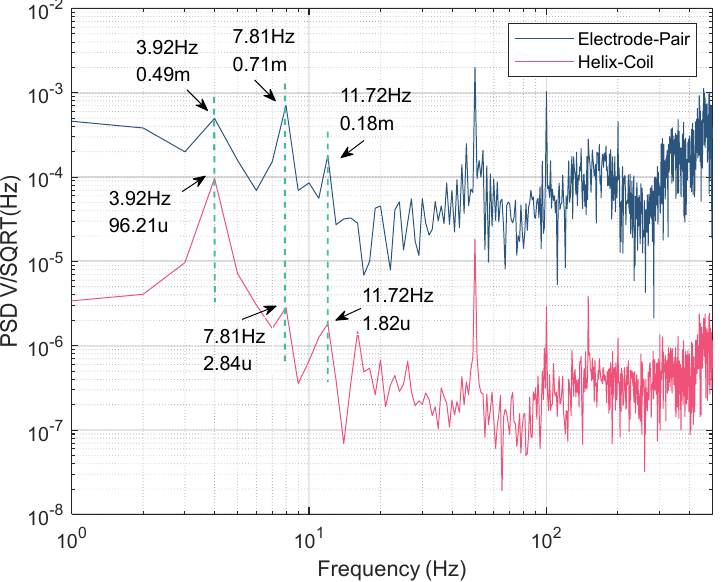
Figure 7. Frequency domain of experimental section signals from static to vibrations. As illustrated in Table 2, when an antenna transitioned from a static to a vibrating state, the time domain peak-to-peak values of two signals increased dramatically. The former grew considerably more than the latter, indicating that polarization noise of the exposed electrode also increased with vibration. From static to low-speed vibration, the background noise level of the two signals increased by 10.51 dB and 9.52 dB, respectively, in the frequency domain, and the highest error was less than 2.1 dB. Due to the increased coil turns, the sensitivity of the helix coil sensor was enhanced. Figure 8 illustrates the received signal under various vibrations. The signals were filtered to reduce spectral leakage by adding a Hanning window prior to